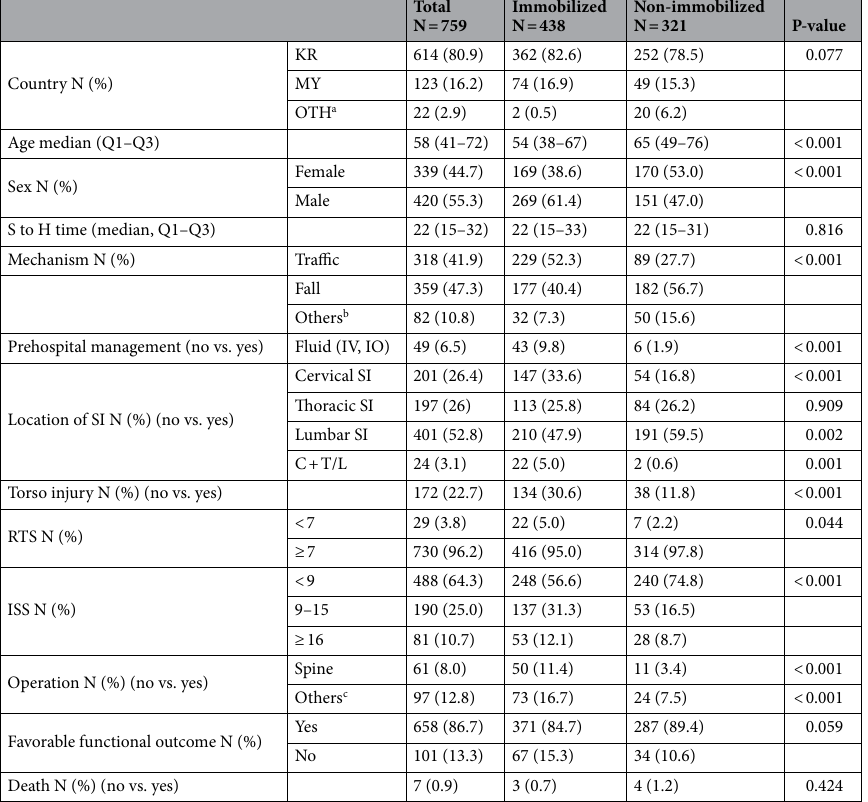
Table 1. Demographics of immobilized and non-immobilized patients. KR Korea, MY Malaysia, OTH others, S to H time scene to hospital time, SI spinal injury, RTS revised trauma score, ISS Injury Severity Score. a Others: Japan and Vietnam. b Others: hit by person or object, choking or hanging, drowning, physical overexertion, another mechanism of injury. c Other operations: One patient could have undergone several operations at the same hospital